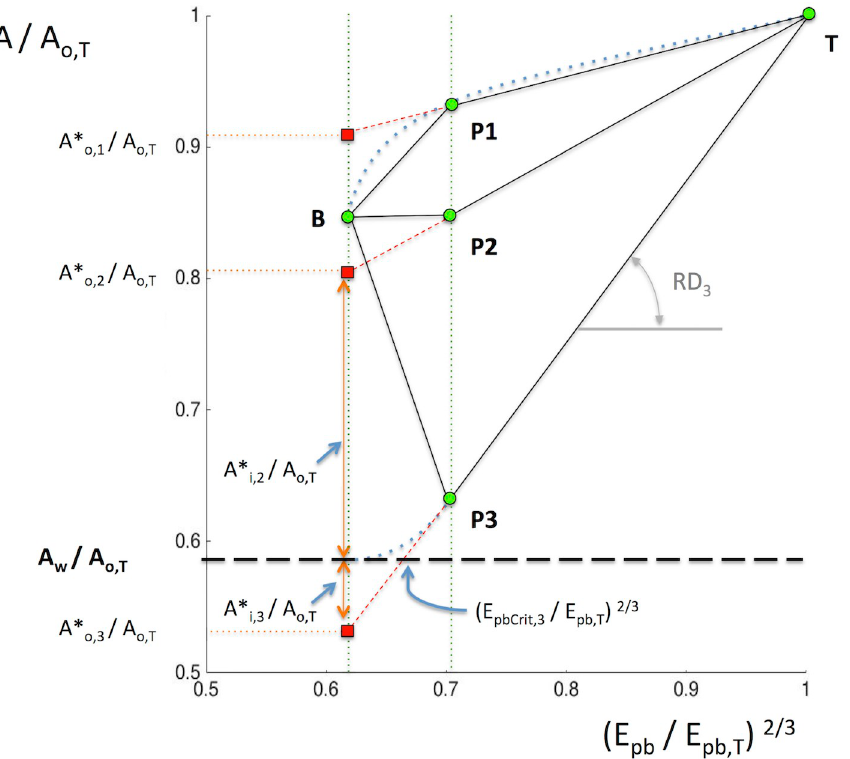
Fig 1. Empirical framework, (for explanation see